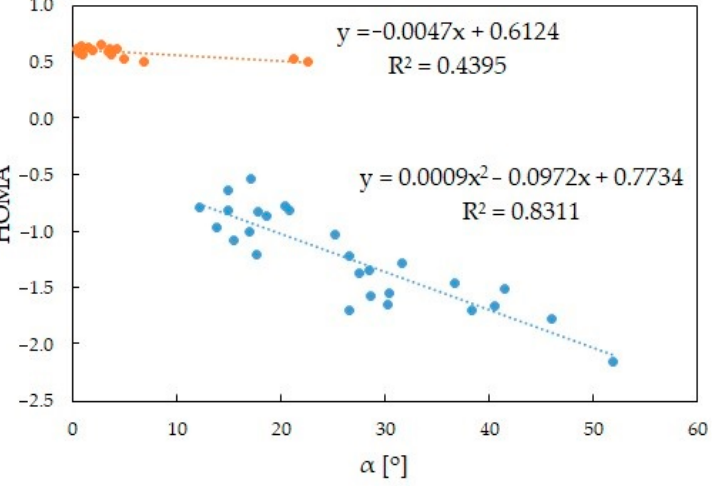
Figure 1. Correlations between the HOMA parameter for the central ring and α angle: yellow—enols, blue—ketones.